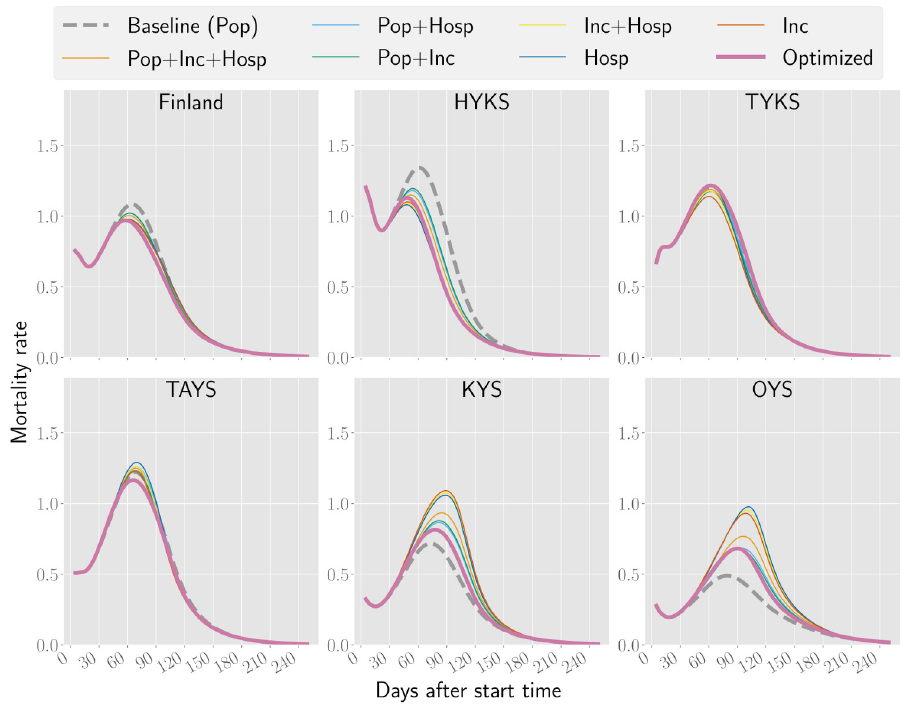
Fig 3. Number of daily deaths per million inhabitants in Finland and the five hospital catchment areas. For this scenario, the basic reproduction number R eff = 1.5 and the mobility value τ = 0.5. For other values of R eff and τ , see S1 File.